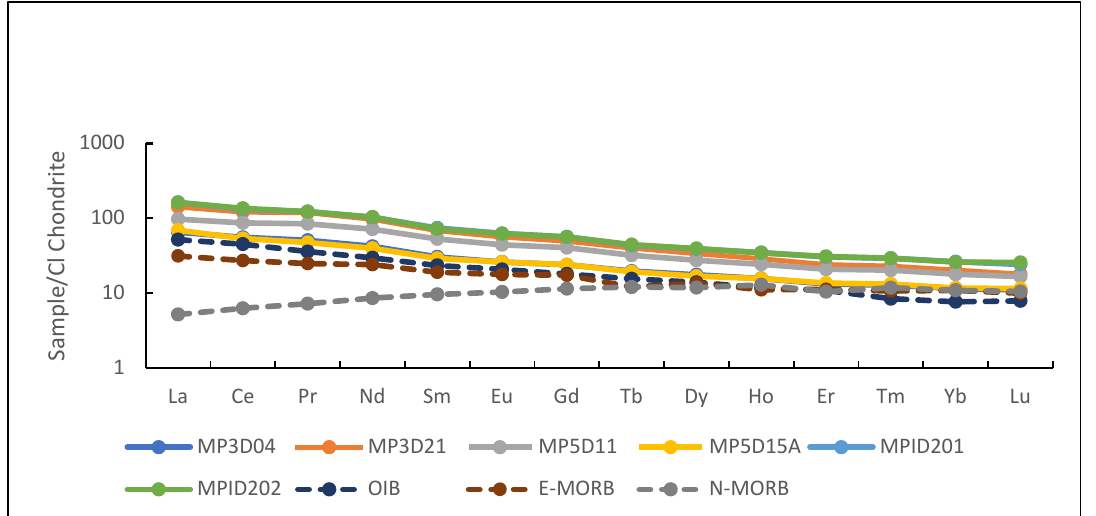
Figure 6. Internationalized REE (ppm) distribution patterns of seamount basalt samples from the Western Pacific. (Cl chondrite datas are after Taylor, S.R. et al., 1985 [31], OIB datas are after Taylor, S.R. et al., 2002 [32], and E ‐ MORB and N ‐ MORB datas are after Klein, E.M., 2003 [33]).